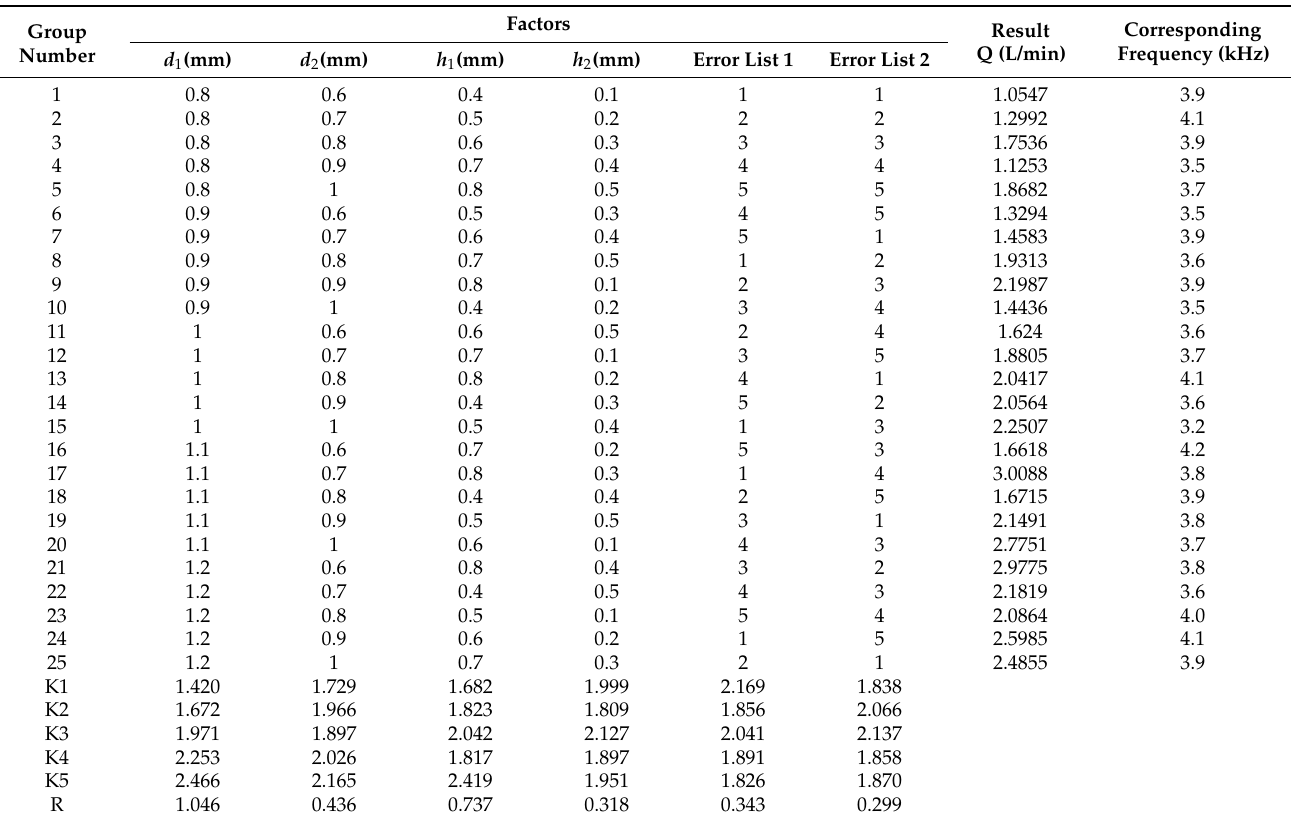
Table 5. Orthogonal table and